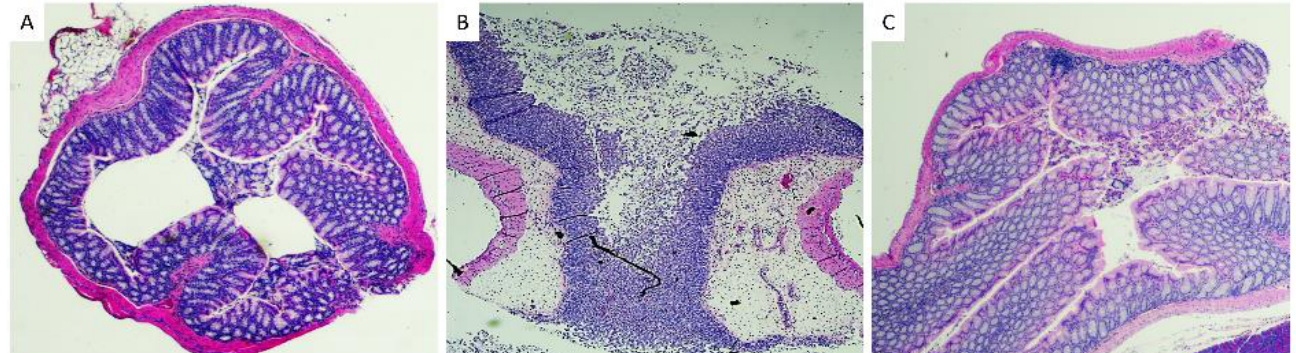
Figure 4. Histological examination of H&E-stained colons of ( A ) uninfected, ( B ) infected symptomatic, and ( C ) infected asymptomatic mice. ( A , C ) show normal microscopic morphology, ( B ) shows severe submucosal edema, marked mucosal and luminal neutrophilic infiltrates, and moderate epithelial necrosis and ulceration.